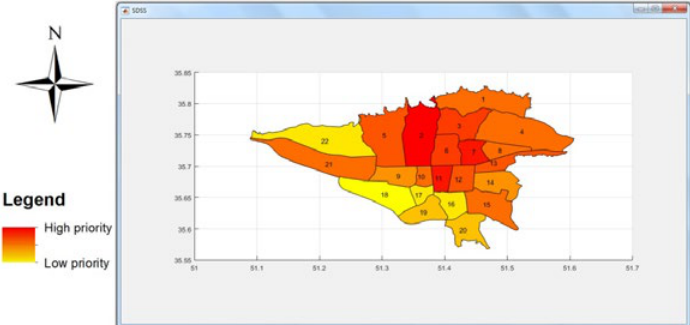
Fig. 9: Prioritization map of 22 districts of Tehran for construction of multiplex buildings based on Fuzzy AHP Method